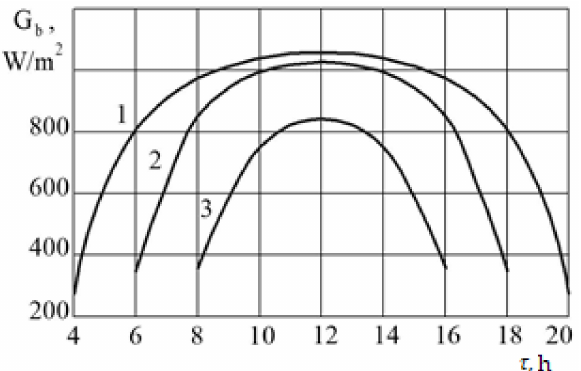
Figure 6. Seasonal changes of the intensity of a direct flux in very clear sky ( T L = 2)—(own research): 1—summer solstice; 2—spring equinox; 3—winter solstice.